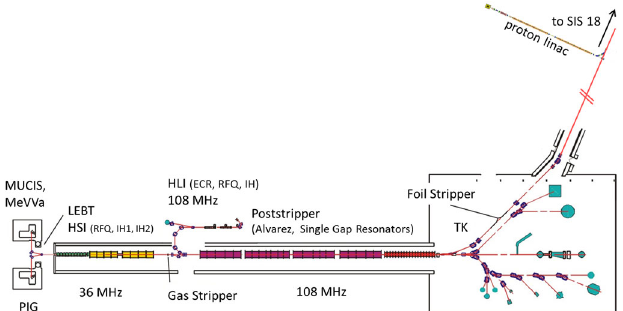
FIG. 1. Schematic overview of the GSI UNILAC, experimental area and new FAIR proton